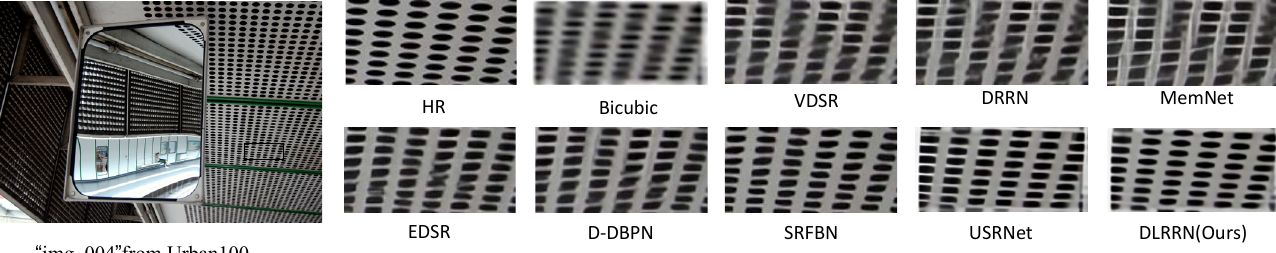
Figure 13. The visualization results of BI × 4, the visual effect restored in the middle area of the image is very clear, but it is a little blurred at the edge of the image.